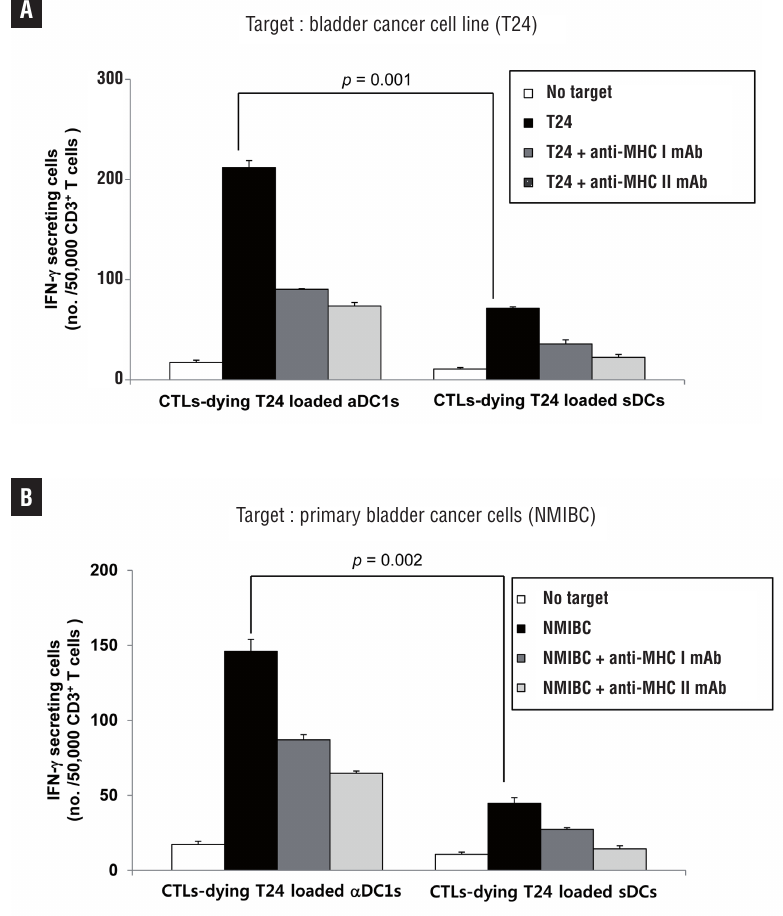
figure 4- comparison of bladder cancer-specific cTL induction in vitro with Dcs loaded with T24 cells against A)the T24 cell line andB)autologous bladder cancer cells (nMIBc). cD8+ T cells primed by T24 cell-loaded α Dc1s showed a larger number of Ifn- γ releases than those stimulated by sDcs (p <0.05). ELIspOT data are the mean (±sD) number of Ifn- γ -secreting cells of triplicate cultures in three independent